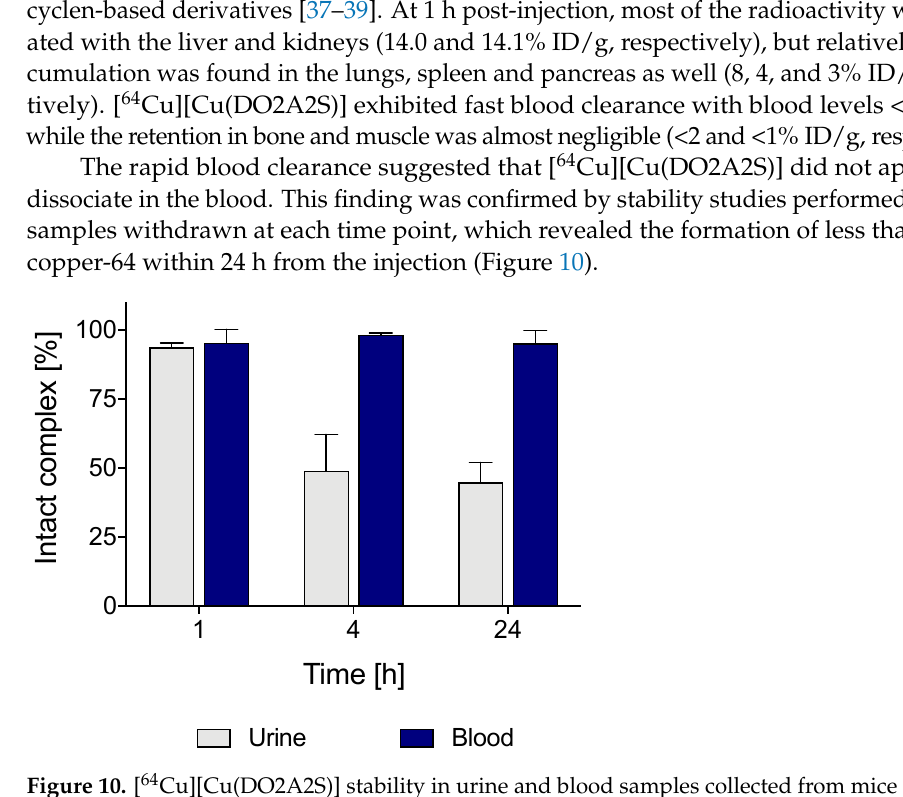
Figure 10. [ 64 Cu][Cu(DO2A2S)] stability in urine and blood samples collected from mice at 1, 4, and 24 h post injection. Data are presented as mean ± SEM ( n = 3/group).